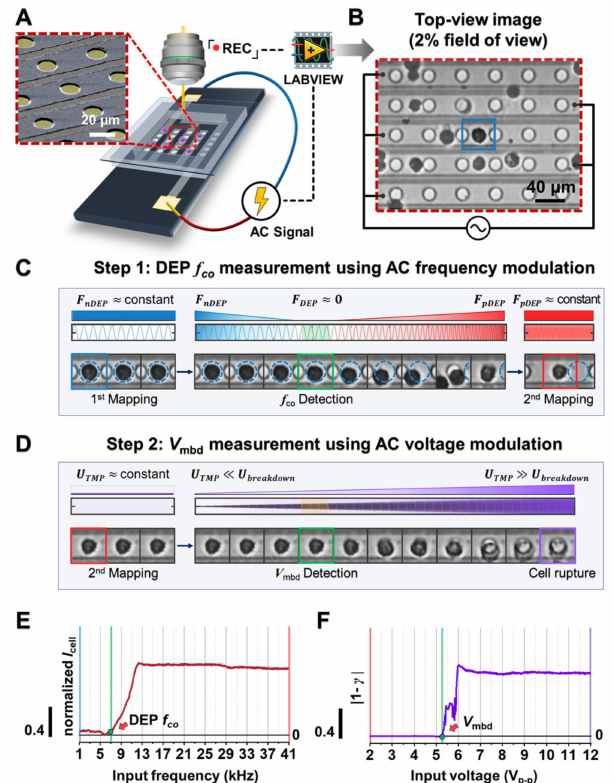
Figure 1. Design and working principle of the proposed platform. ( A ) Schematic illustration of the platform. The red inset is the SEM image of the chip substrate (the original SEM image was also attached in Figure S1 in Supplementary Materials). ( B ) The representative top-view image demonstrating that cells were grounded and trapped between the neighboring circular electrodes under the influence of negative and positive DEP forces. Please also see Figure S4 in Supplementary Materials for a detailed description of the cell trapped position. ( C , D ) Signal application mode for monitoring cell dielectric behavior. Using cell tracking analysis, each cell was labeled with DEP crossover frequency and membrane breakdown voltage, which was induced as a phenomenological parameter from the sequential electric signal modulation of AC frequency ( C ) and AC voltage ( D ). ( E , F ) Dielectric response of a cell during the increase of AC frequency and AC voltage, respectively. In each signal, the transition moment (green line) was determined as DEP f co ( E ) and V mbd ( F ) (see Materials and